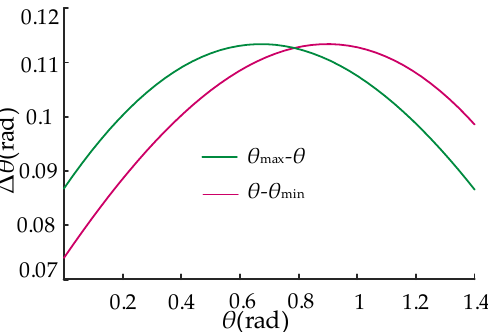
Figure 5. The relationship of ∆ θ to the initial phase θ when θ ∈ (arcsin λ , arccos λ) .